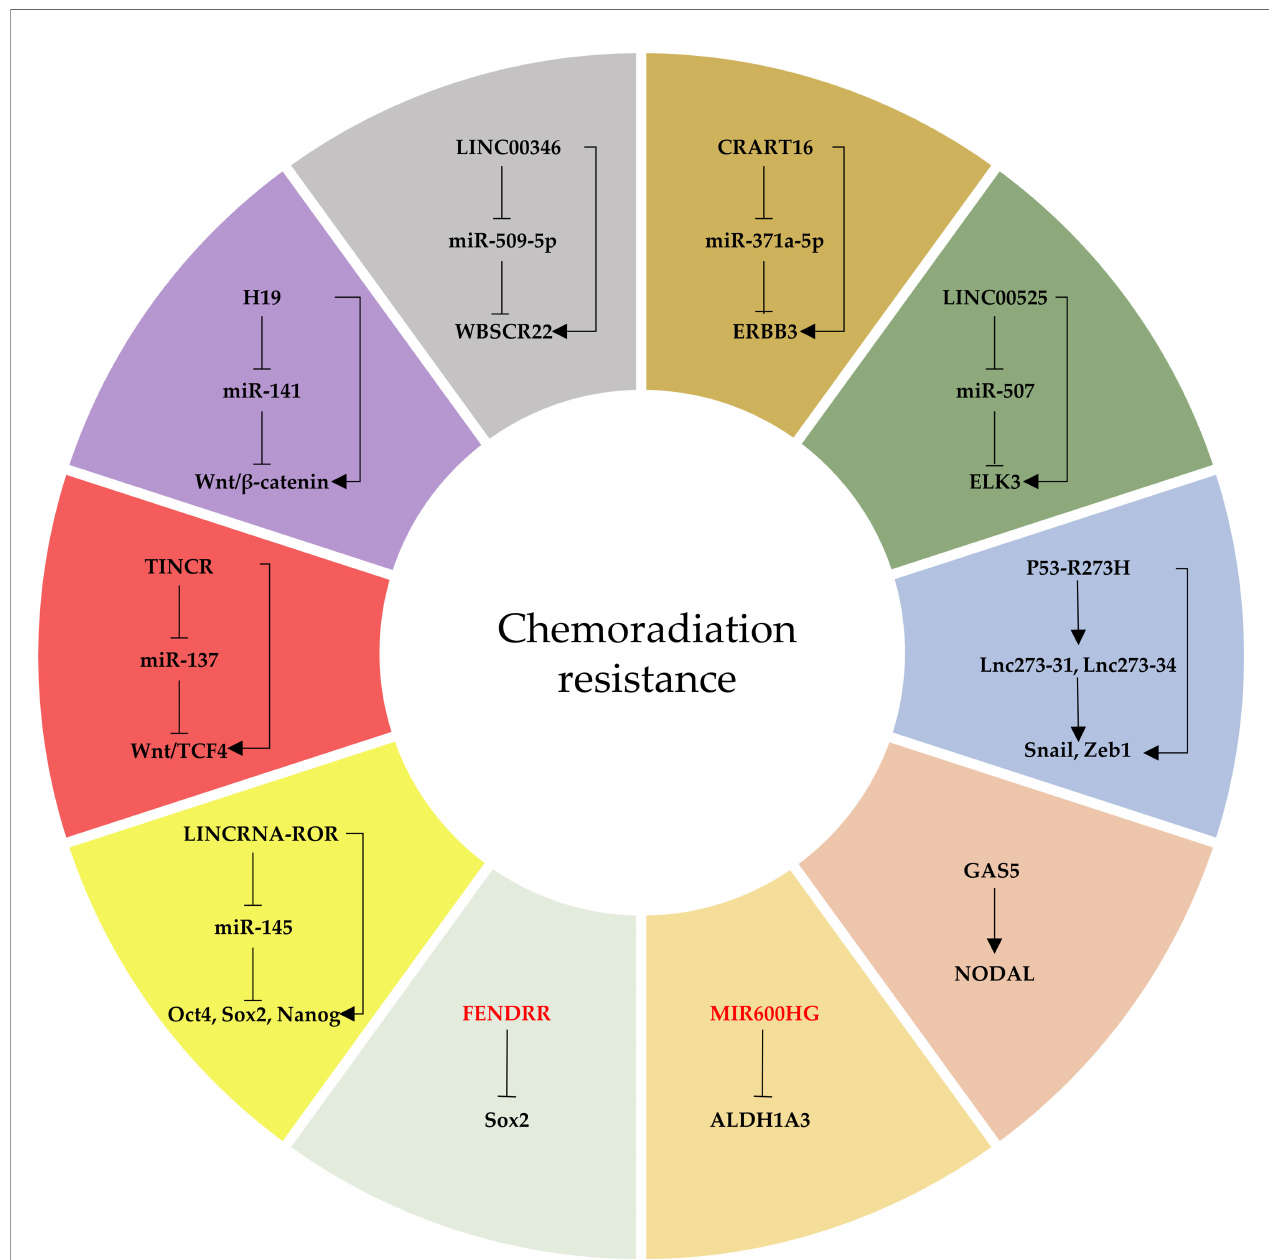
FIGURE 3 | The network of lncRNAs that regulate CRCSC-mediated chemoradiation resistance. Oncogenic lncRNAs are indicated in black and tumor-suppressor lncRNAs in